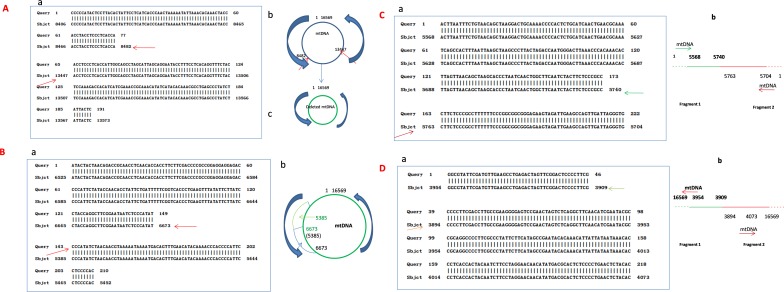
Example of mtDNA recombinant.Blast result by using the sequence of fragments against the whole sequence of mtDNA genome. Query indicate the sequence of fragment, sbjct indicate the whole sequence of mtDNA genome. A. Deletion: Common mtDNA deletion 4977 between nt8482-13447 of mtDNA; a. indicate that a fragment between 8482 and 13447(red arrow) has been cut out, and a new small size mtDNA genome (deletion) has been formed as showed at b. B.F-type rearrangement: a.shows two fragments joining in the same direction, 5’ numbering is 6673, 3’ numbering is 5385 according to L-Strand. b. shows the model of F-type rearrangement, indicate the end of one fragment is 6673, and the end of another fragment is 5385, with the new mtDNA has duplicate sequence between nt5385-6673 (arrows show). C.R1-type rearrangement: a.shows two fragments jointed together to form new fragment with 5’ numbering is 5740, and 3’is 5763, the gap of numbering between 5’ joining point and 3’ joining point is 7,b.suggested model of R1 type rearrangement: one fragment from 1–5740 joined with another fragment in reverse orientation beginning is 5763 and end is 1. D. R2-type rearrangement: a.shows two fragments jointed together to form new fragment with 5’ numbering is 3909, and 3’ is 3894, the gap of numbering between 5’ breakpoint and 3’ breakpoint is 13, b.suggested the model of R2 type rearrangement: one fragment from 16569–3909 joined with another fragment, which is in reverse orientation beginning is 3894 and end is 16569.